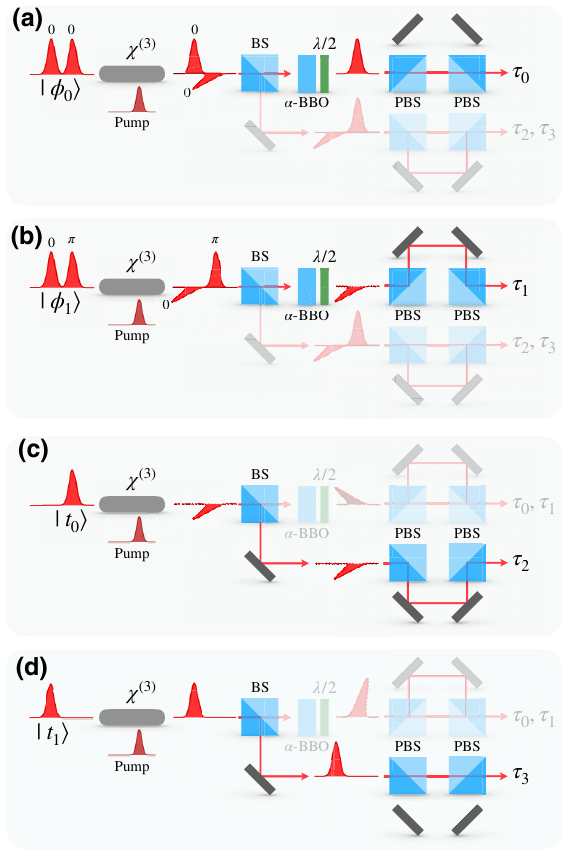
FIG. 1. The measurement of time-bin states. The conceptual experimental setup for (a),(b) the phase-basis measurement and (c),(d) the time-basis measurement. A strong pump is over- lapped with the t 0 time bin inside a χ ( 3 ) material, rotating its polarization. A 50:50 beam splitter randomly selects one of two measurement settings, i.e., the phase basis (upper) or time basis (lower). In the scenario where the input state is prepared in one basis but measured in the other basis (the shaded part of the setup), the measurement outcomes are random and will later be sifted. χ ( 3 ) , third-order nonlinear material; BS, beam splitter; λ/ 2, half-wave plate; PBS, polarizing beam